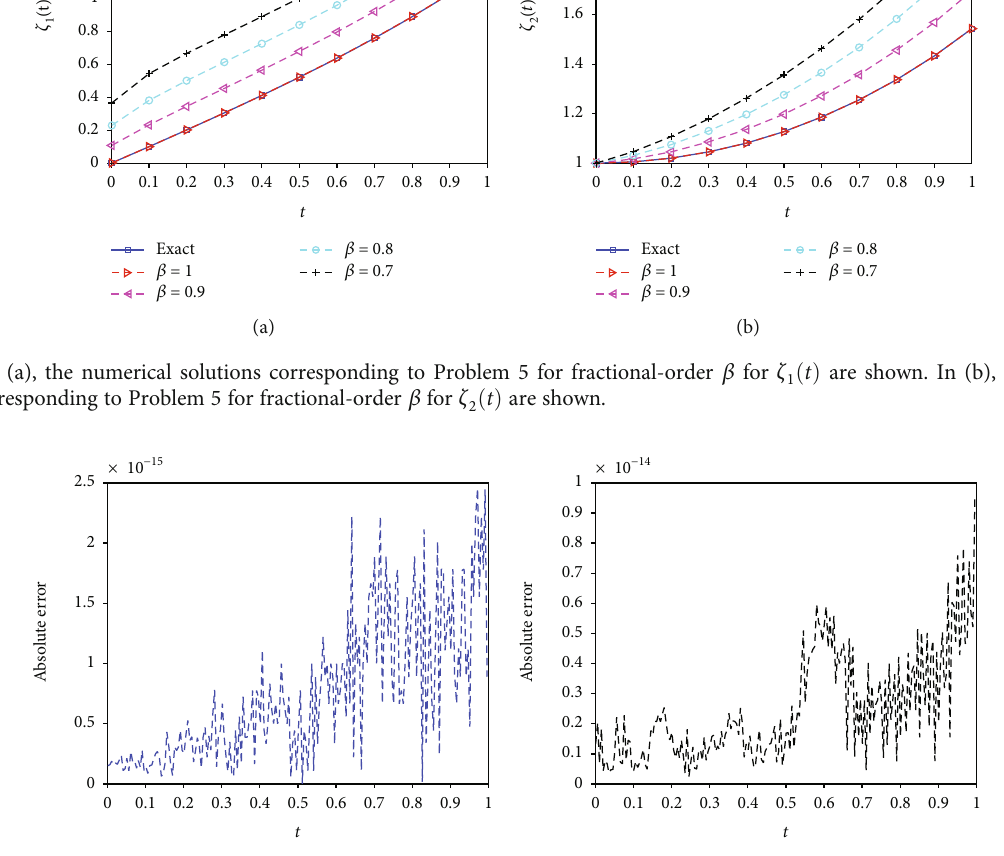
ð t Þ corresponding to Problem 5 is shown. In (b), for β = 1 and t ∈ ½ 0, 1 (cid:2) , the 1